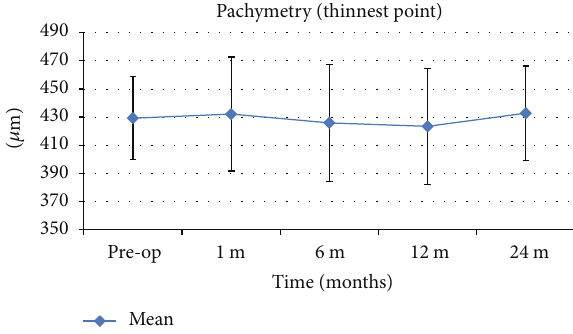
Figure 4: Pachymetric changes after MyoRing implantation and CXL. 𝜇 m: micrometer. The error bars represent the SD in 𝜇